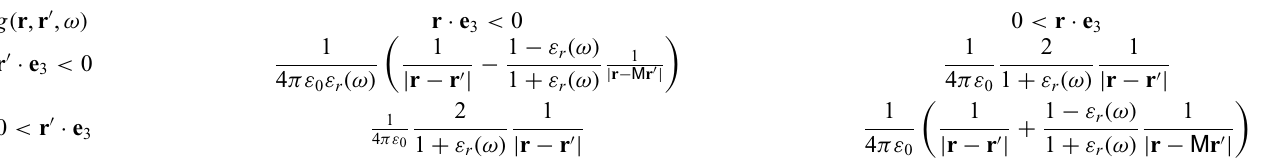
TABLE III. The Green function for a dielectric half-space with ε r (ω) for r · e 3 < 0 and vacuum for r · e 3 > 0. g ( r , r (cid:3) , ω) r · e 3 < 0 0 < r · e